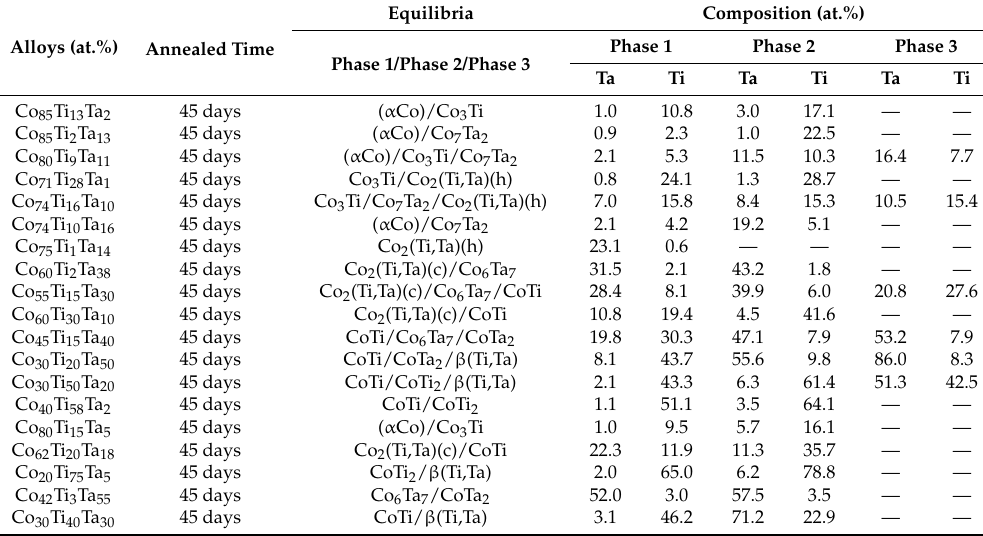
Table 2. Equilibrium composition of the Co-Ti-Ta ternary system at 1000 ◦ C determined in the present work.